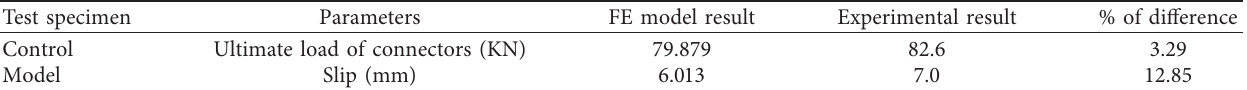
Figure 7: Comparison of FE model and experimental result: (a) Failure mode of concrete slab and (b) Deformed shape of the shear connector. Table 4: Comparison between FEA models and experimental results.